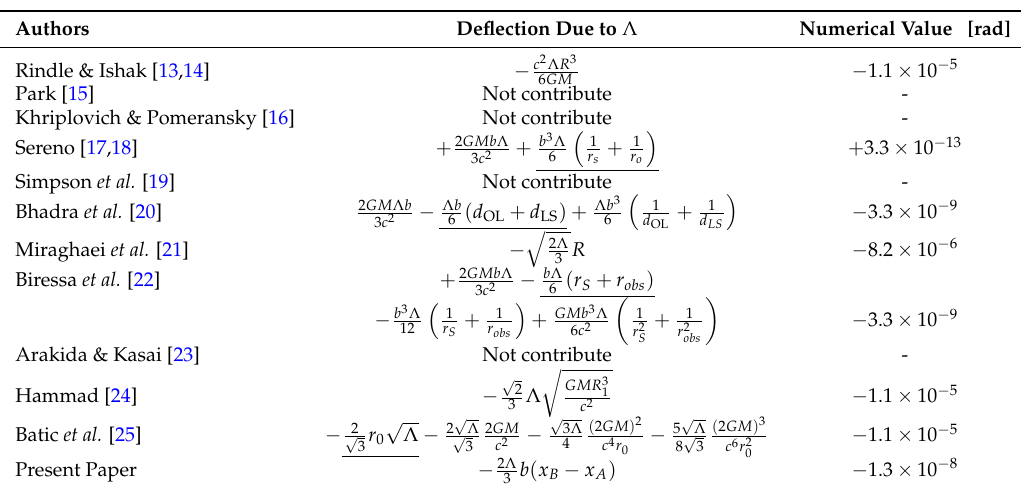
Table 1. Comparison with previous results.. We estimate the numerical value using c = 3.0 × 10 8 [ m/s ] , G = 6.674 × 10 − 11 [ m 3 · kg − 1 · s − 2 ] , Mass of galaxy M ≈ 10 12 M (cid:12) = 2.0 × 10 42 [ kg ] , Λ ≈ 10 − 52 [ m − 2 ]